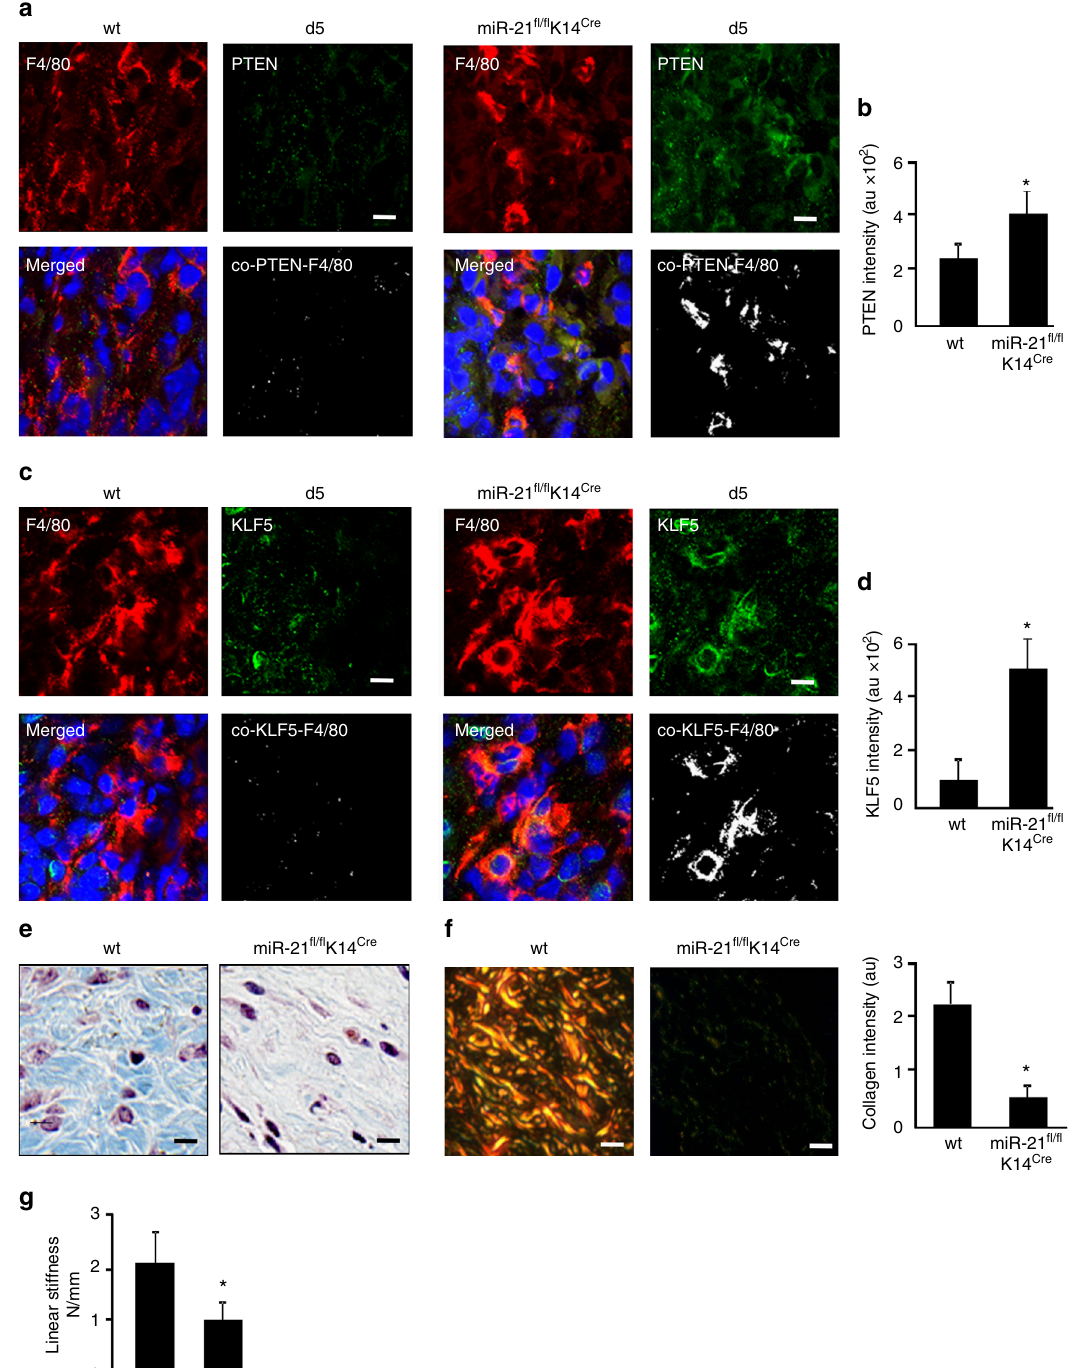
Fig. 9 Keratinocyte-speci fi c depletion of miR-21 impairs macrophage transition and healing. a Macrophage (F4/80, red) and KLF5 (green) immunostaining of d5 wound tissue from wt and miR-21 fl / fl K14 Cre mice, n = 5, scale bar = 10 µ m. b Quanti fi cation of KLF5 expression in wt (miR-21 fl / fl ) and miR-21 fl / fl K14 Cre mice, n = 5, Student ’ s t test p < 0.05. c Macrophage (F4/80, red) and PTEN (green) immunostaining of d5 wound tissue from wt and miR-21 fl / fl K14 Cre mice, n = 6, scale bar = 10 µ m. d Quanti fi cation of PTEN expression in wt (miR-21 fl / fl ) and miR-21 fl / fl K14 Cre mice, n = 6, p < 0.05. e Masson's Trichrome staining showing collagen (blue) levels in d10 healed wounds in wt(miR-21 fl / fl ) and miR-21 fl / fl K14 Cre mice, n = 5, Student ’ s t test p < 0.05, scale bar = 10 µ m. f Picro-sirius staining showing collagen (yellow) levels of d10 healed wounds in wt(miR-21 fl / fl ) and miR-21 fl / fl K14 Cre mice, n = 5, p < 0.05, scale bar = 10 µ m. Bar graph presents quantitation of blue pixels (collagen) in Masson ’ s trichrome in wt (miR-21 fl / fl ) and miR-21 fl / fl K14 Cre mice, n = 4, Student ’ s t test p < 0.05. g Linear skin stiffness measurement of healed wounds on d14 post-wounding from miR-21 fl / fl K14 Cre and wt (miR-21 fl / fl ) mice, n = 6, Student ’ s t test p <